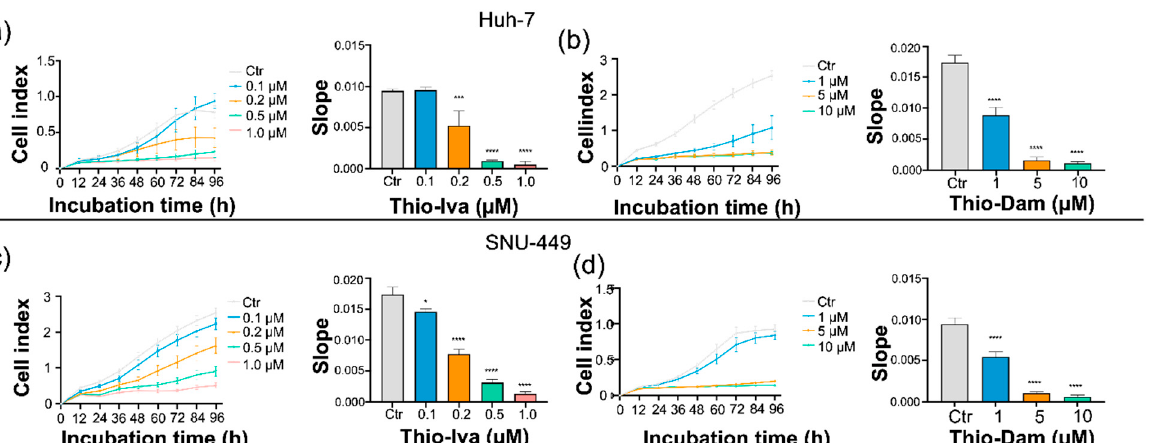
Figure 2. VEGFR-2 inhibition by novel compounds. Enzymatic kinase profiling on 32 kinases re- vealed multi-kinase inhibition of Thio-Iva, with the most pronounced effects on VEGFR-2 kinase ( a ). Dose–response curve for Thio-Iva-induced VEGFR-2 kinase inhibition ( b ). Data are given as means ± SD of n = 2–3 independent determinations per kinase. Western blot of Thio-Iva and Thio- Dam-induced inhibition of VEGFR-2 phosphorylation in Huh-7 ( c ) and SNU-449 ( d ) cells after 24 h of incubation, confirming the VEGFR-2 inhibiting effects of both compounds on the cellular level.